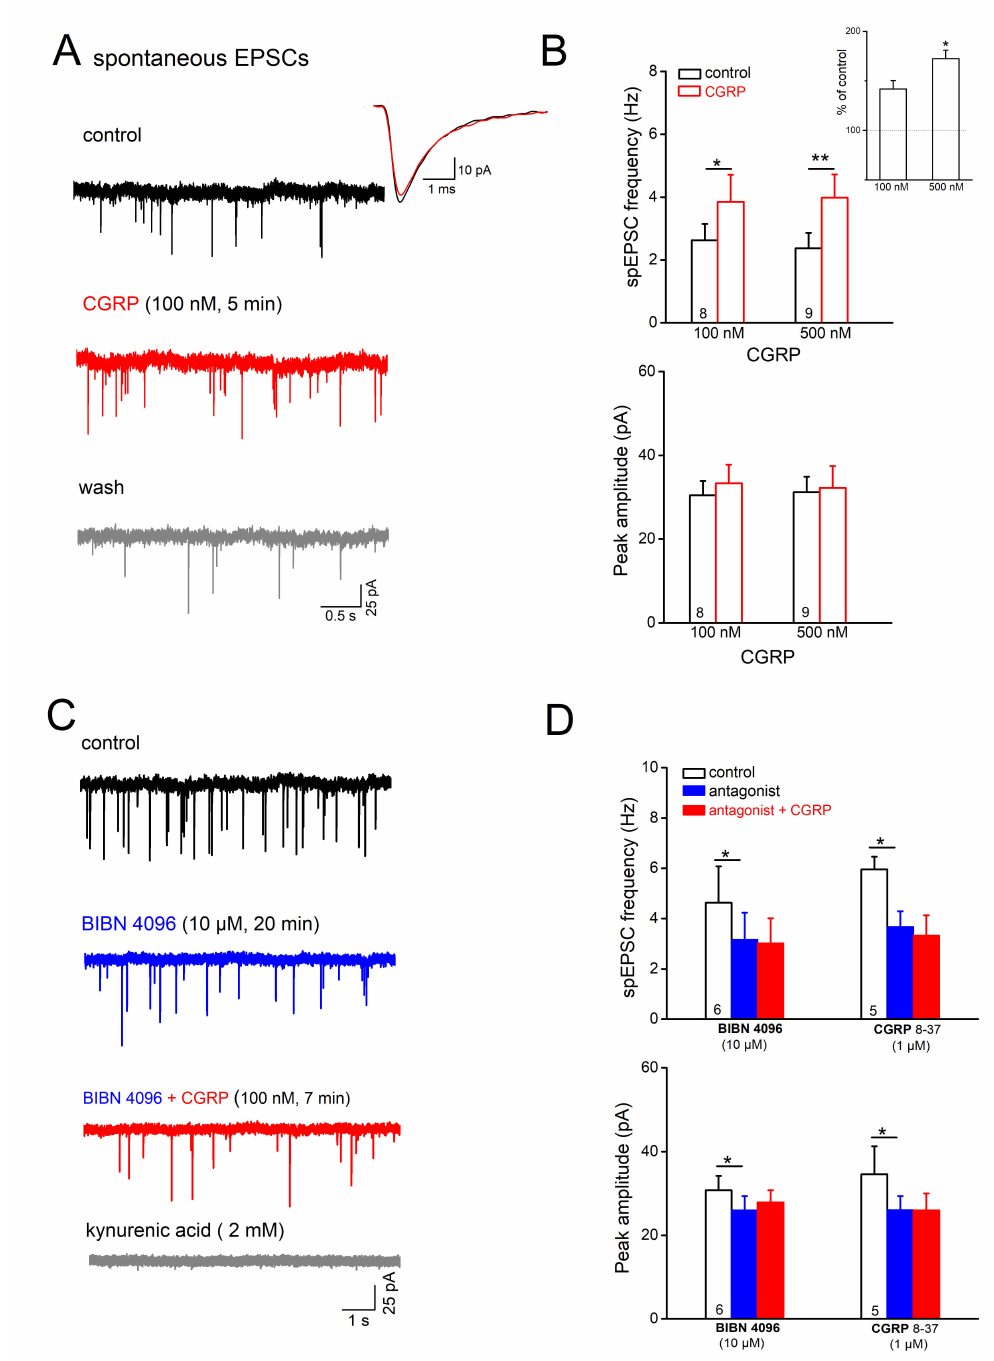
Figure 5. Calcitonin gene-related peptide (CGRP) facilitates excitatory synaptic drive onto Sp5C laminae I/II cells. Spon- taneously occurring excitatory postsynaptic currents (spEPSCs) were monitored under whole-cell voltage-clamp mode at − 70 mV, in the presence of antagonists for GABA A Rs and GlyRs. ( A ) Raw traces of spEPSCs from a lamina I cell were collected before CGRP application (control), 5 min in CGRP (100 nM) and 10 min after wash. Superimposed traces on the right represent the averaged events from the cell before (black trace) and during drug application (red trace). ( B ) Histograms summarize the effects of acutely applied CGRP on the frequency and the averaged peak amplitude of spEPSCs. Inset in up-right corner with the normalized changes in spEPSC frequency further reinforces the dose-dependent effect of CGRP. ( C ) Typical responses of spEPSCs to CGRP (100 nM) in the presence of a potent non-peptide antagonist BIBN 4096BS (10 µ M, 20 min). Kynurenic acid (KA, 2 mM) was applied at the end of this experiment to verify the glutamatergic origin of spEPSCs. ( D ) Summary of the dampening effects of CGRP receptor antagonists on spEPSCs in Sp5C I/II cells. * p < 0.05; ** p <